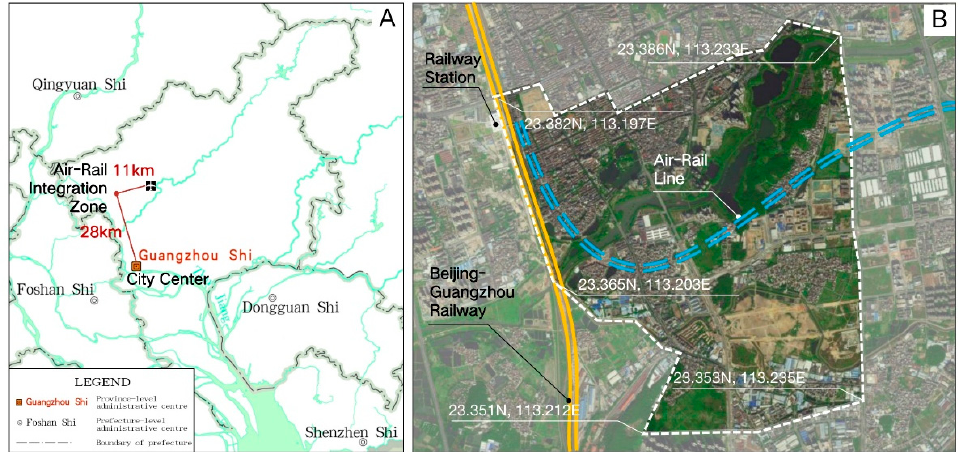
Figure 13. Location and current situation of air–rail integration zone (( A ) showing the location of site, 28 km north of the city center and 11 km west of the airport, and ( B ) showing the current situation of the site beside the Beijing–Guangzhou Railway, consisting of rural and industrial communities, with the future air–rail line passing through).